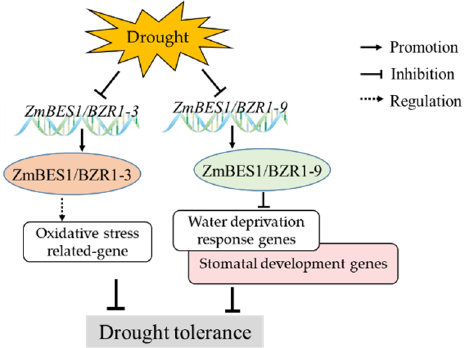
Figure 9. Diagram of the ZmBES1/BZR1-3 and ZmBES1/BZR1-9 regulated the network in the drought response.